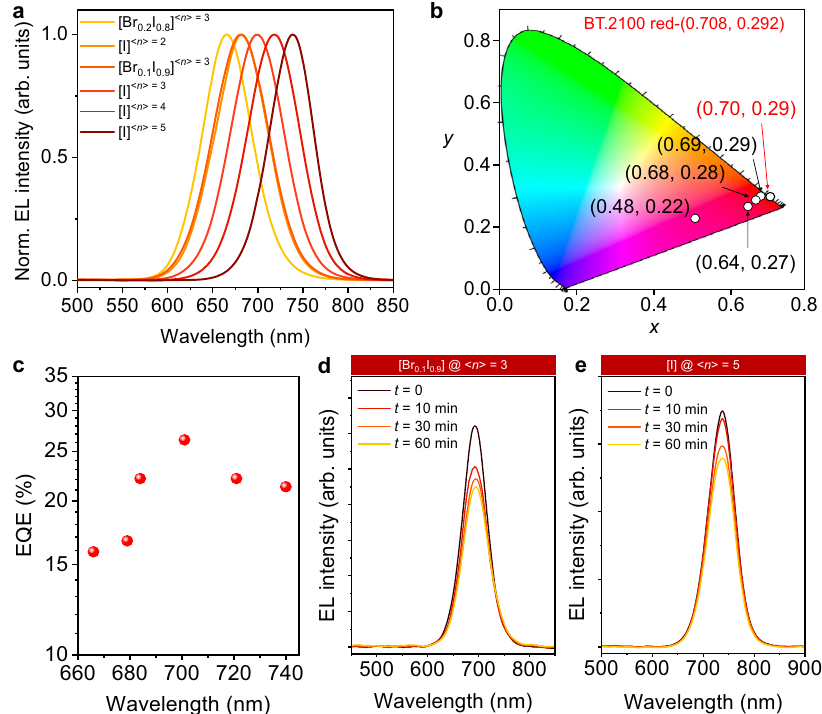
Fig. 5 | Wavelength tunability and spectral stability. a , b EL spectra ( a ) of PPT based quasi-2D perovskite LEDs with different compositions and the correspond- ing CIE coordinates ( b ).Typically, < n >= 3 represents thatthe stoichiometric ratio of precursor solution follows the general chemical formula of (PPT) 2 FA n − 1 Pb n I 3 n +1 with a nominal n =3. c The relationship of EQEs against EL peaks. d , e Time evo- lution tracking of EL spectra for LEDs fabricated from < n >=3 with 10% Br+90% I